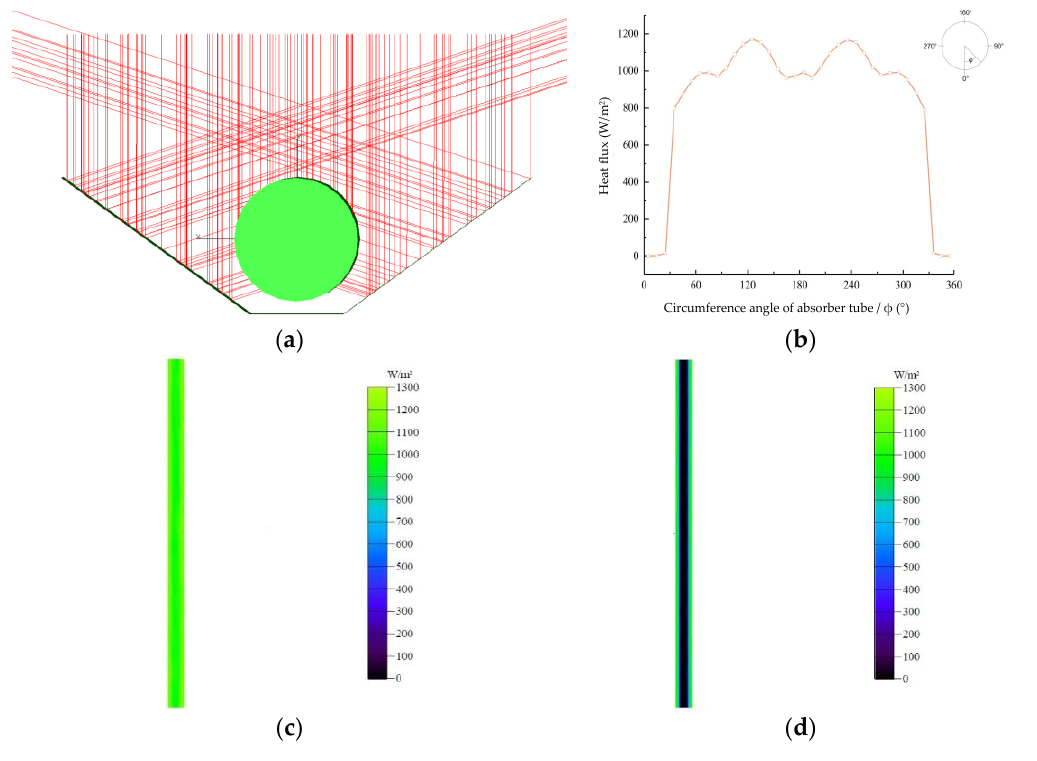
Figure 10. ( a ) TTC solar ray tracing results, ( b ) average circumferential solar radiation at the cross- section, ( c ) Upper surface solar radiation distribution along the radial direction, ( d ) lower surface solar radiation distribution along the radial direction.